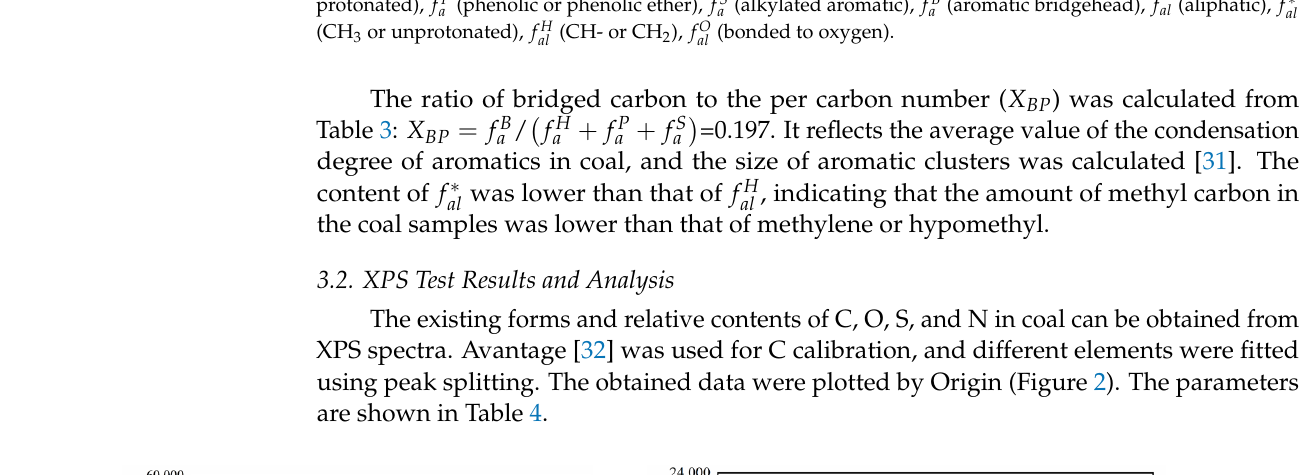
Table 3. Carbon structural parameters of Kerjian coal.